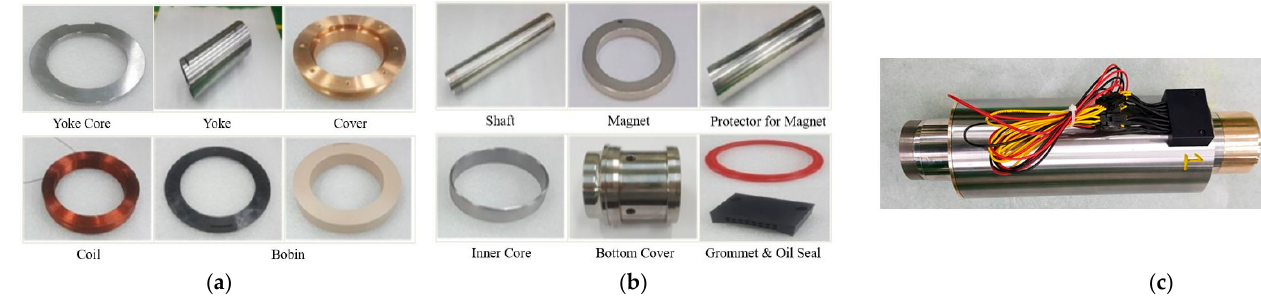
Figure 7. Overall linear generator assembly components and final prototype: ( a ) stator assembly; ( b ) mover assembly; ( c ) final prototype.